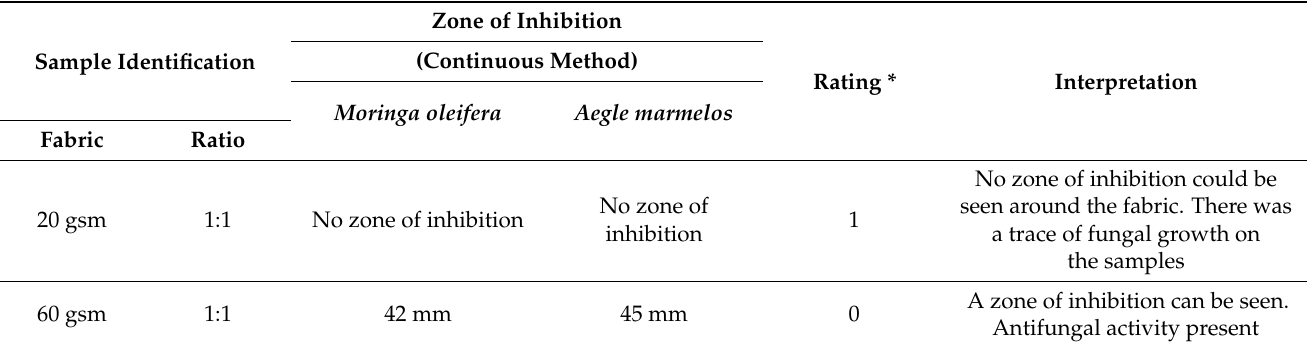
Table 4. Antifungal test AATCC 30-III 2013.